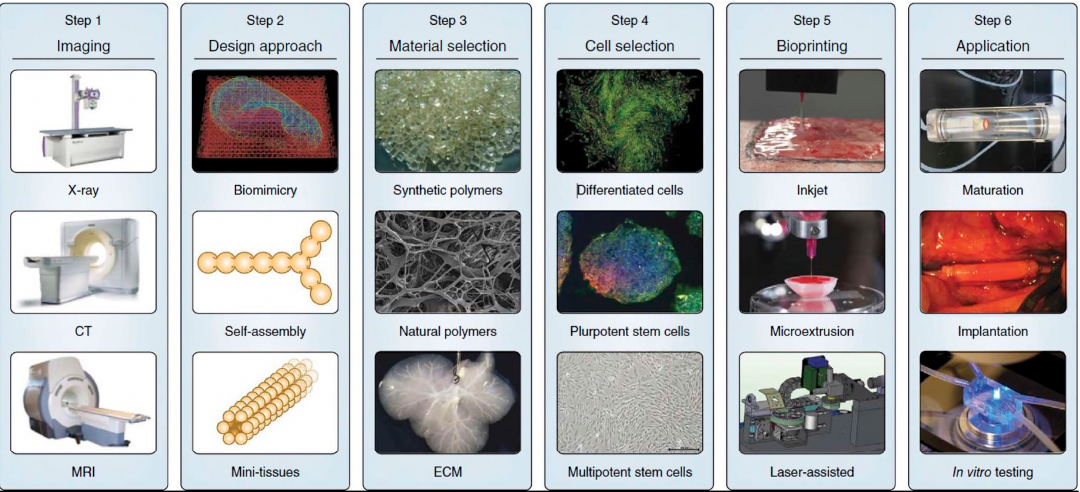
Figure 2. The general step-wise procedure for bioprinting 3D tissues. Reprinted with permission from Reference [12] .